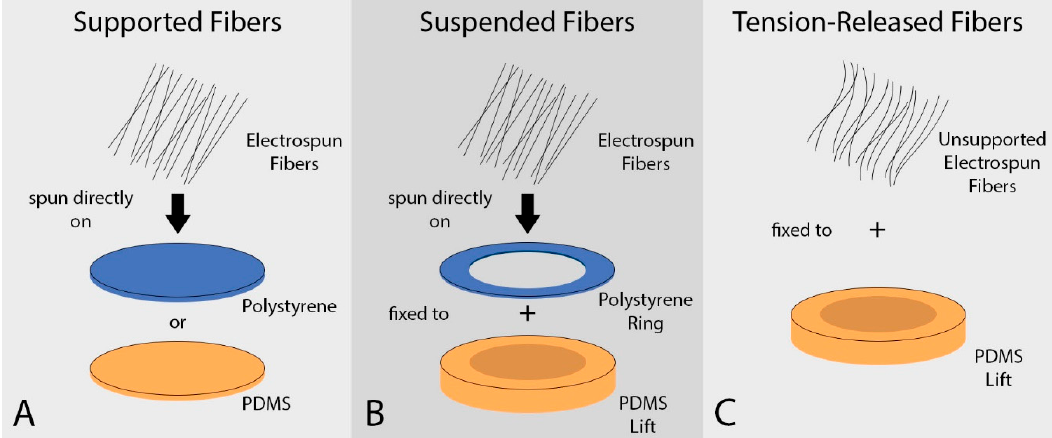
Figure 1. Schematic of Electrospun Fiber Mats. Electrospun fiber mats (EFMs) were either spun